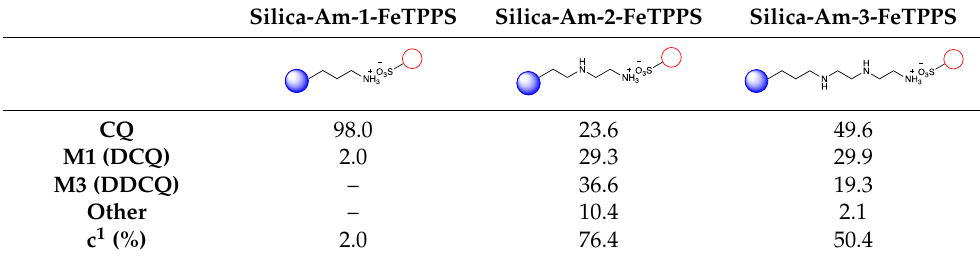
Table 3. Component analysis of immobilzed FeTPPS metalloporphyin onto amino-functionalized silica particles (Silica-Am-1-FeTPPS, Silica-Am-2-FeTPPS and Silica-Am-3-FeTPPS) catalyzed biomimetic oxidation of chloroquine (CQ) in continuos-flow mode. Tests were performed in triplicate, Stdr < 5%.